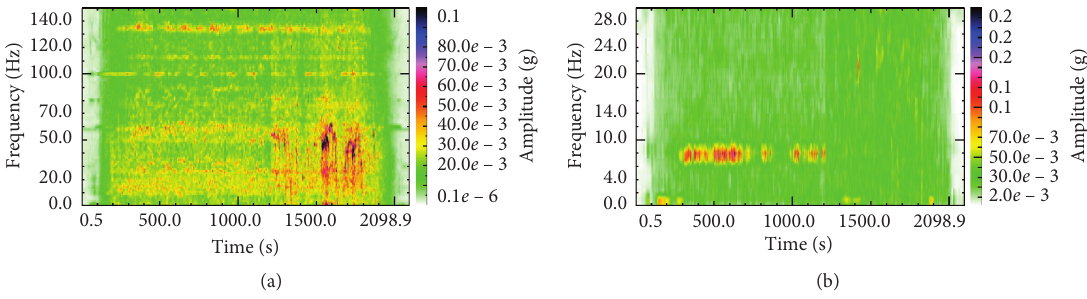
Figure 16: Spectrum of acceleration on CBSE traction converter in (a) lateral and (b) vertical directions.